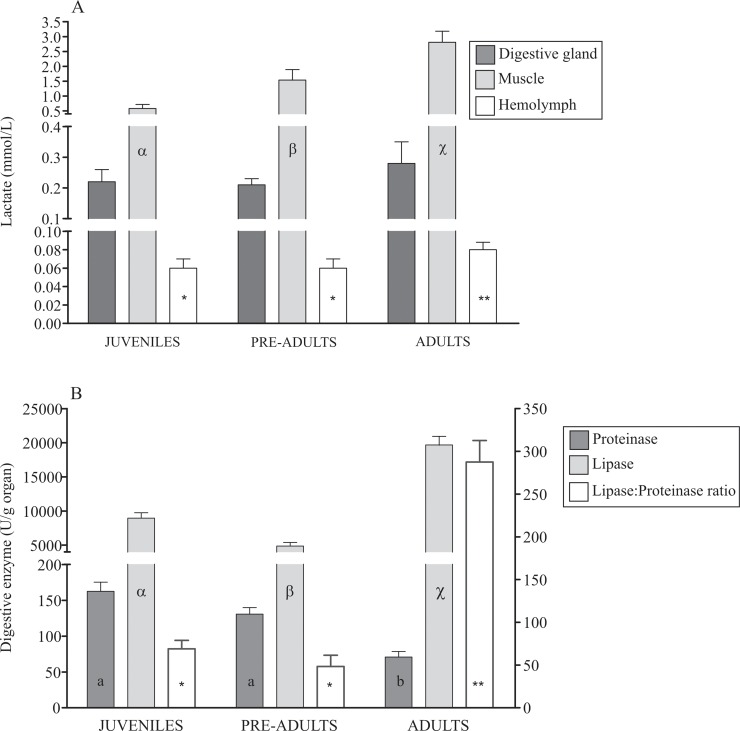
Lactate concentrations of the midgut gland, muscle and hemolymph (A); activity of digestive enzyme and lipase:proteinase ratio in the midgut gland (B) of Lithodes santolla at different ontogenetic stages. Different letters (a, b or α, β, χ) and asterisks (single or double) indicate statistical differences among ontogenetic stages (p<0.05).